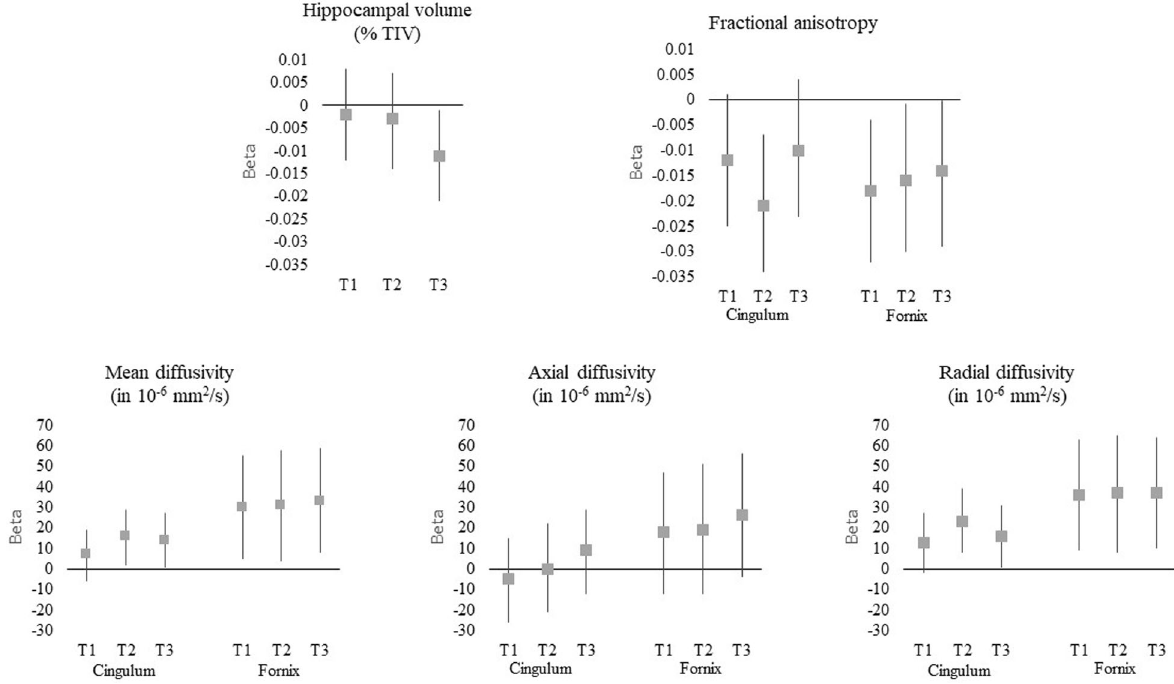
Fig. 1 Association between the levels of anti-HSV IgG in terciles and hippocampal volume or white matter integrity. Adjusted linear regression models. 3C and AMI cohorts. T1, T2, and T3: 1st, 2nd, and 3rd terciles of anti-HSV IgG, TIV: total intracranial volume, fornix and cingulum: parahippocampal fornix and cingulum. The bars show the regression coef fi cients with their 95% con fi dence interval (reference: uninfected subjects). Linear regression models are adjusted for age at serology, sex, level of education, presence of at least one allele of APOE4, hypertension, diabetes, and